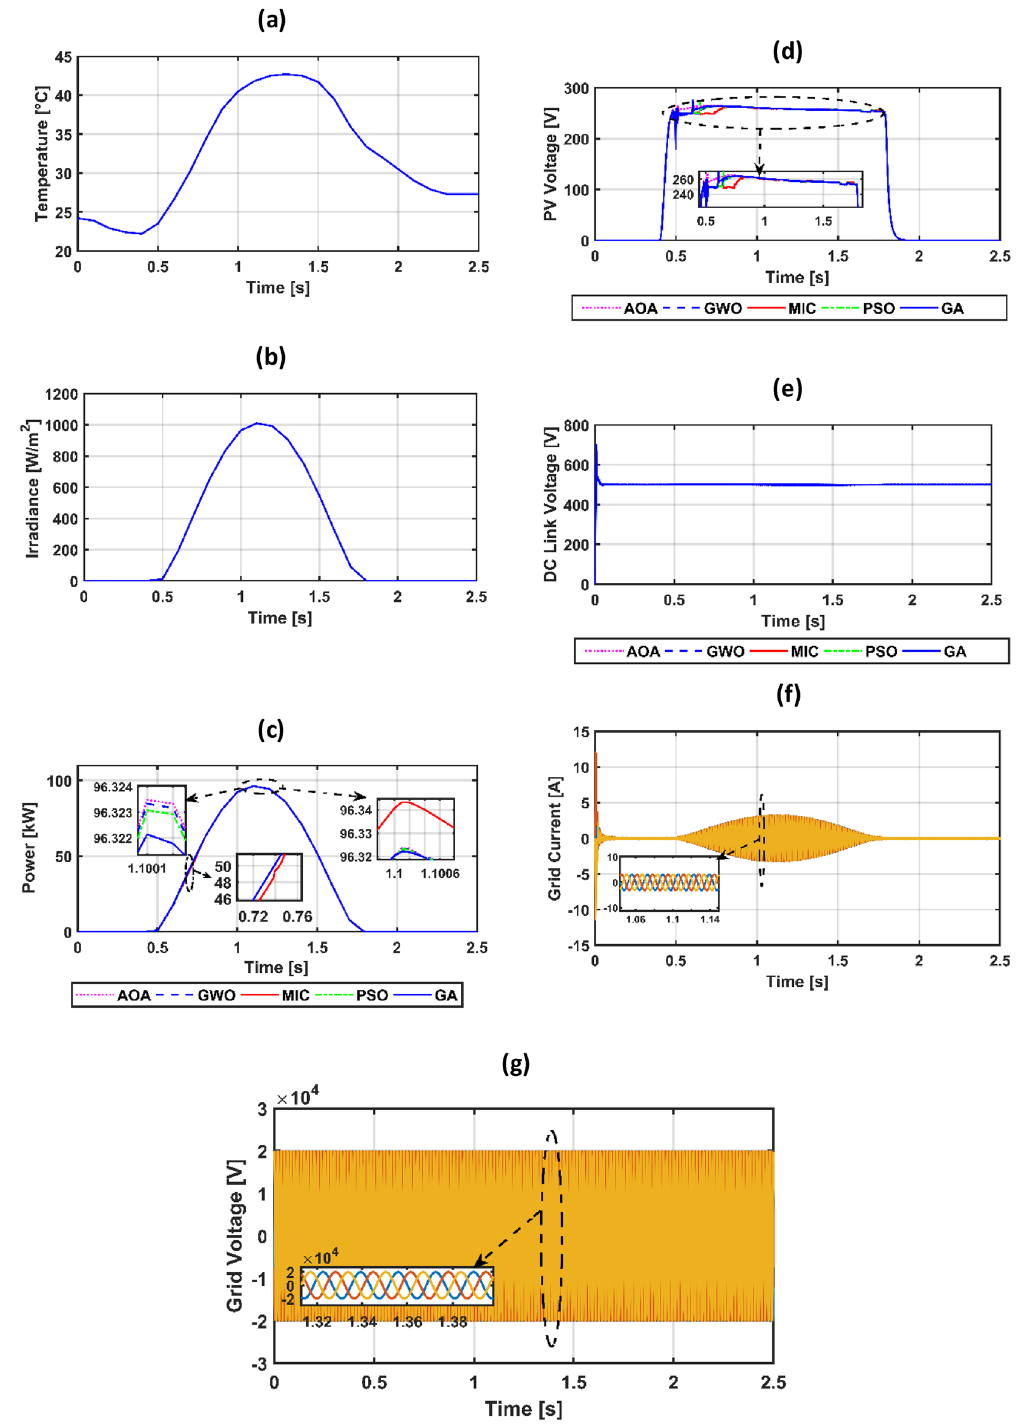
Figure 12. ( a ) realistic temperature, ( b ) realistic irradiance, ( c ) PV power, ( d ) PV voltage, ( e ) voltage of DC link, ( f ) grid current-based AOA, ( g ) grid voltage-based